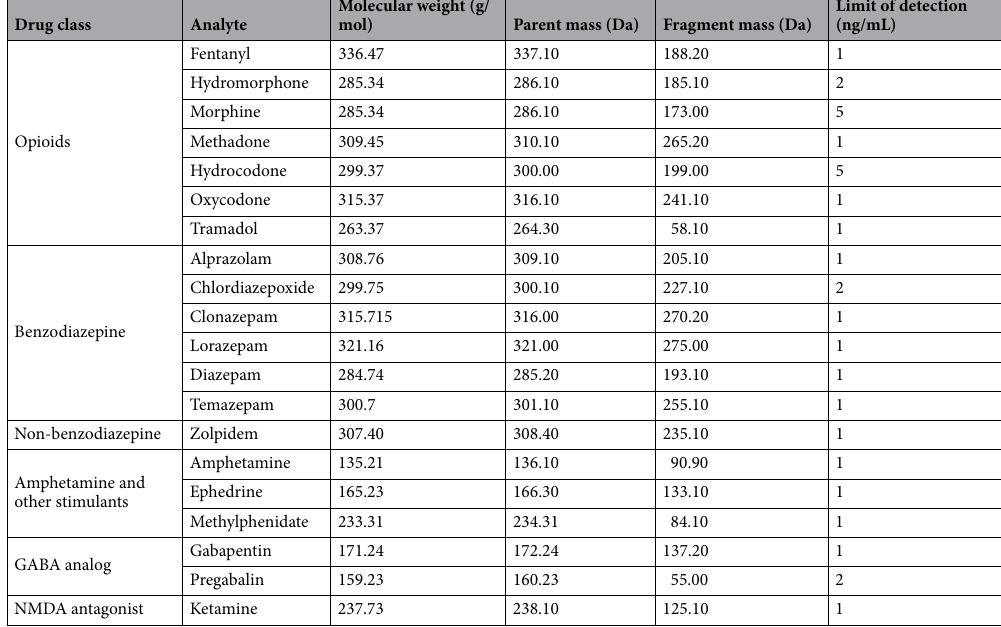
Table 1. LC–MS Multiple reactions monitoring (MRM) method details. An MRM method was developed for a subset of the 34 drugs tested with SafeMedWaste, ranging across multiple classes and DEA schedules. The MRM transitions are listed, as well as the limits of detection for each